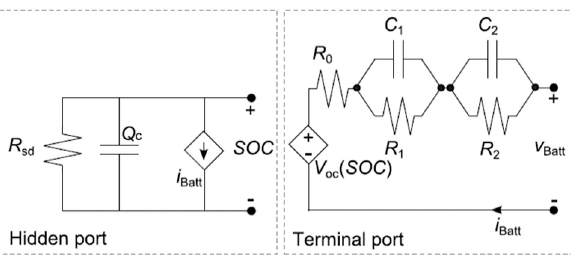
Figure 3. A pulsed charge test.